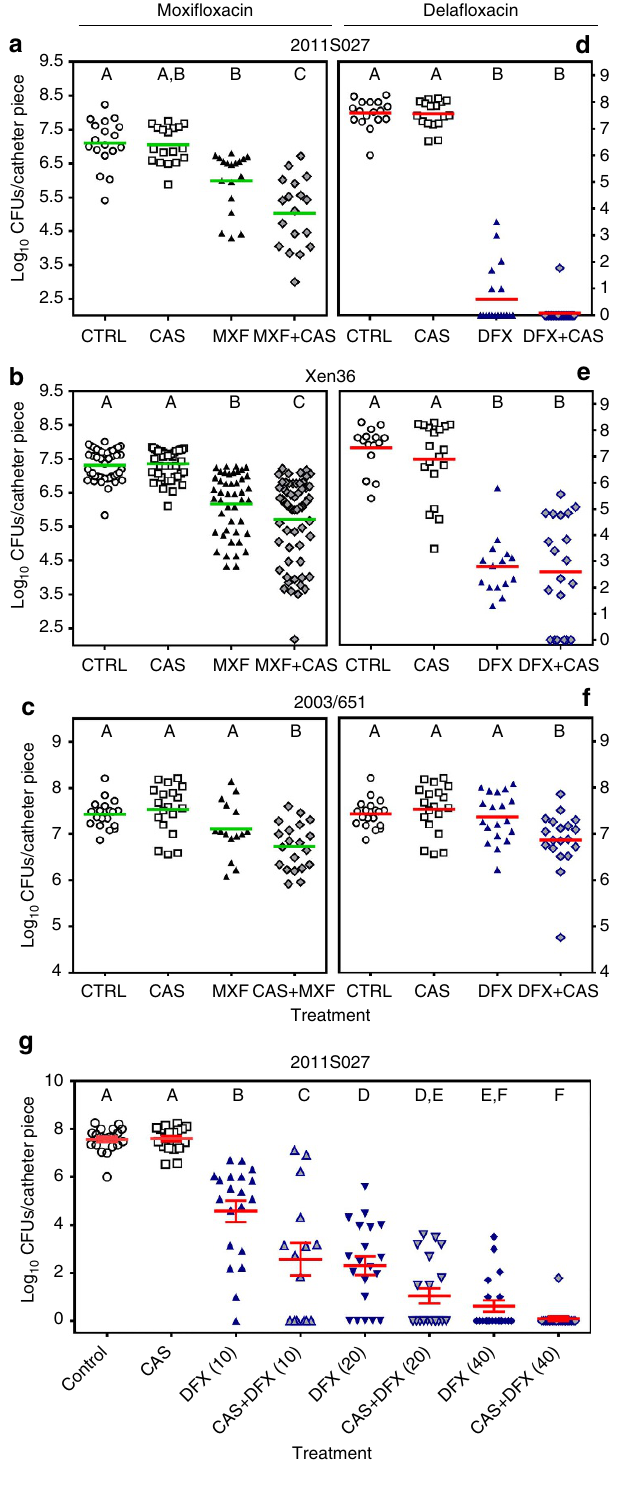
for the activity of delafloxacin alone or combined with caspofungin on biofilms from the clinical isolate 2011S027 in the mouse subcutaneous biofilm model. Animals were treated for 7 days with caspofungin (CAS; 4mgkg (cid:2) 1 of body weight) once daily, delafloxacin (DFX; 10, 20 or 40mgkg (cid:2) 1 of body weight) twice daily, or with delafloxacin at each of these doses combined with caspofungin 4mgkg (cid:2) 1 once daily. Data are presented as the number of CFU (in log 10 units) recovered from each individual catheter, with the mean value (and s.e.m. in g ) shown in green or red colour for all catheters (five catheters per animal; three or four animals per group; one experiment with clinical isolates and three experiments with strain Xen36). Statistical analysis (one-way ANOVA; Tukey post-hoc test): groups with different letters are significantly different from one another ( P o